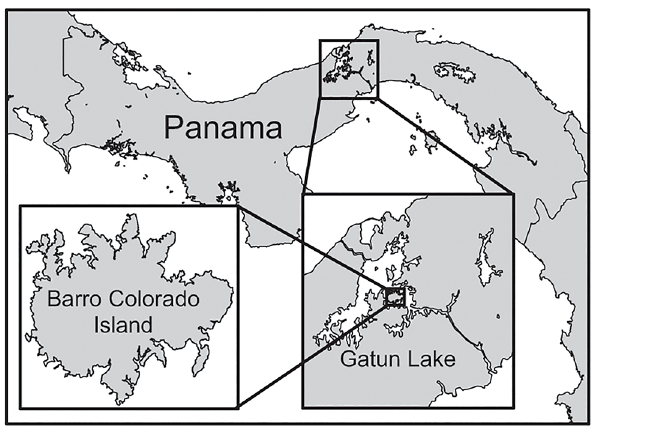
Fig 1. Map of Barro Colorado Island (BCI),